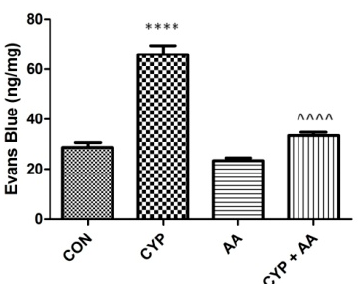
Figure 6. The effects of pretreatment with asiatic acid (30 mg/kg/day for 14 days by oral gavage) on cyclophosphamide (CYP, 200 mg/kg, i.p., single dose) induced changes in Evans Blue extravasation into bladder tissue. All results are presented as the mean ± SEM (n = 15 rats per group). The obtained data was assessed by the one-way ANOVA followed by Tukey’s post hoc test. * when significantly different from the control group. ˆ when significantly different from the CYP group. **** or ˆˆˆˆ p < 0.0001. One-way ANOVA for Evans Blue extravasation: F(3.56) = 72, p < 0.0001. AA: asiatic acid; CON: control; CYP: